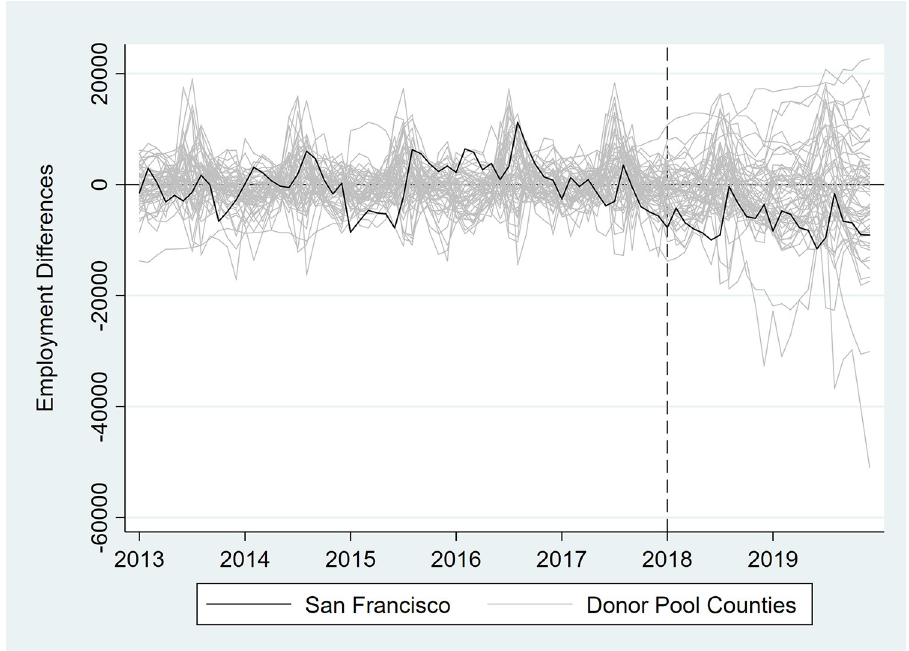
Fig 7. Differences in employment outcomes between each county and its synthetic control for total employment.